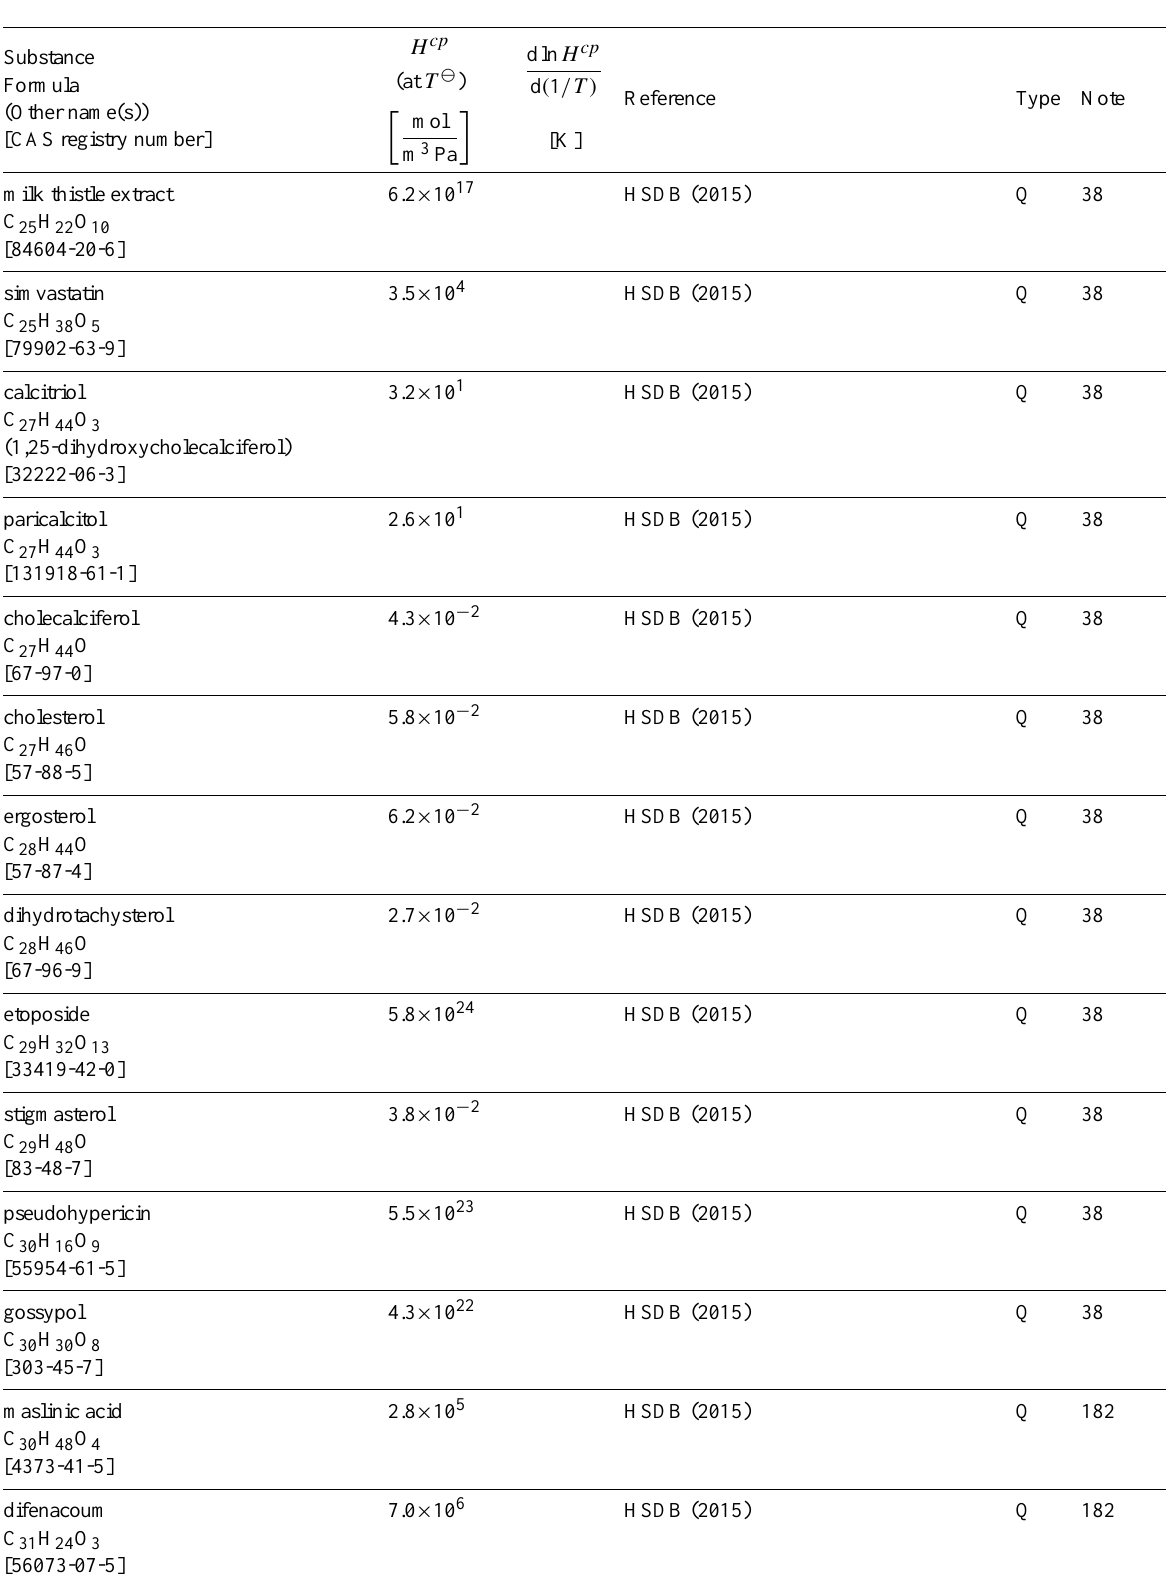
Table 6: Henry’s law constants for water as solvent